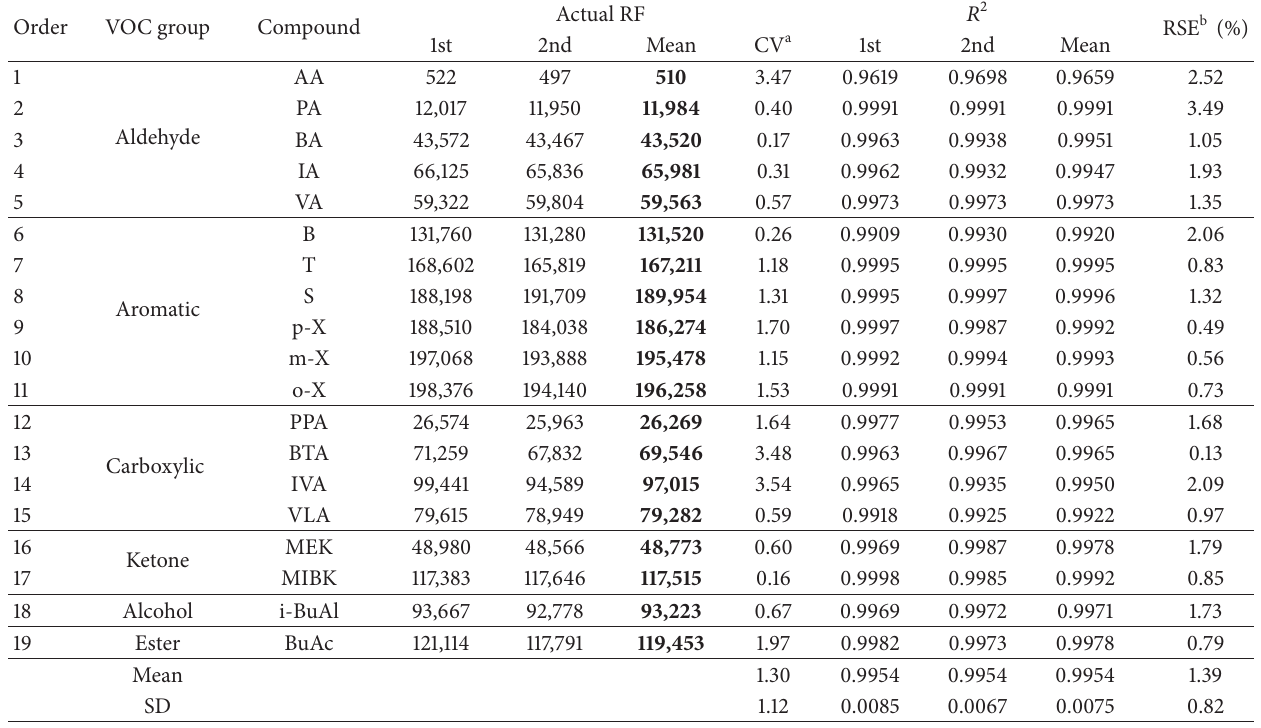
Table 4: Results of replicate calibration of 19 reference VOCs based on ST/TD approach used in this study: (1) response factor (RF), (2) determination of coefficient ( 𝑅 2 ), and (3) relative standard error (RSE,